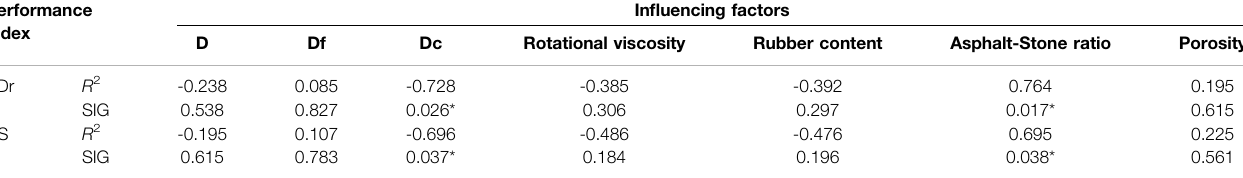
TABLE 7 | Correlation analysis of mixture performance and in fl uencing factors. Performance